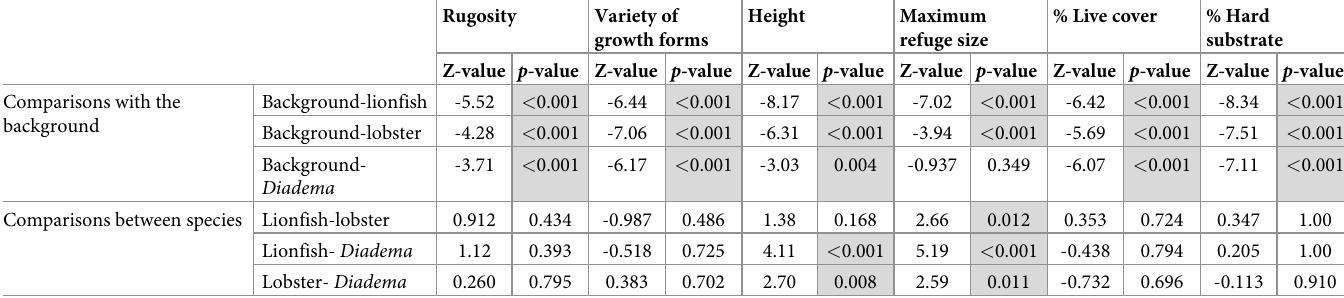
significantly more complex habitat than Diadema (Dunn tests, p < 0.05 for all; Table 1). Table 1. Dunn tests